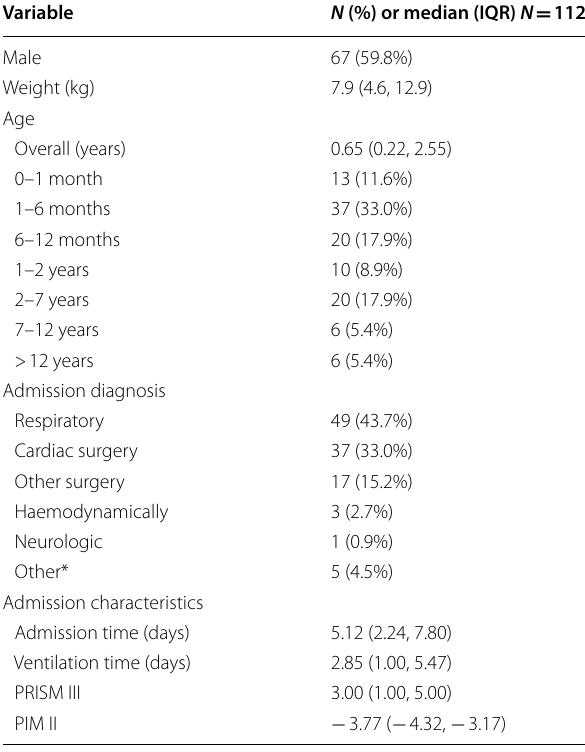
Table 1 Characteristics of the cohort